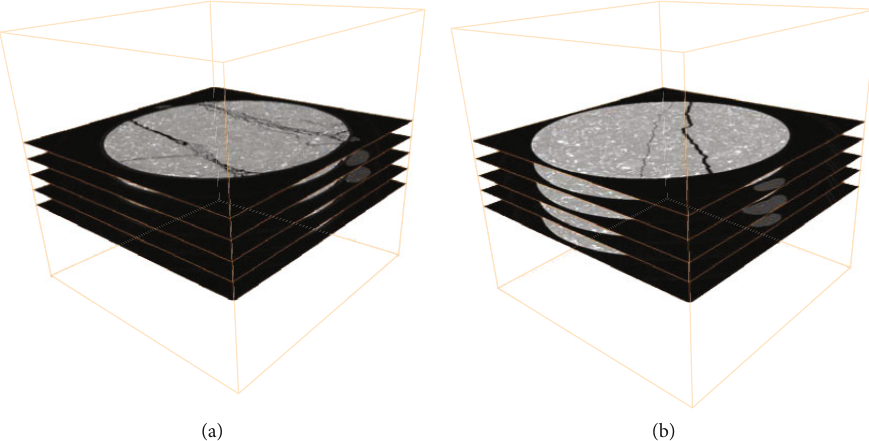
Figure 11: Scheme the positions of reconstructed CT slices to describe the brittle fracture of rock bridge, taking two samples for example